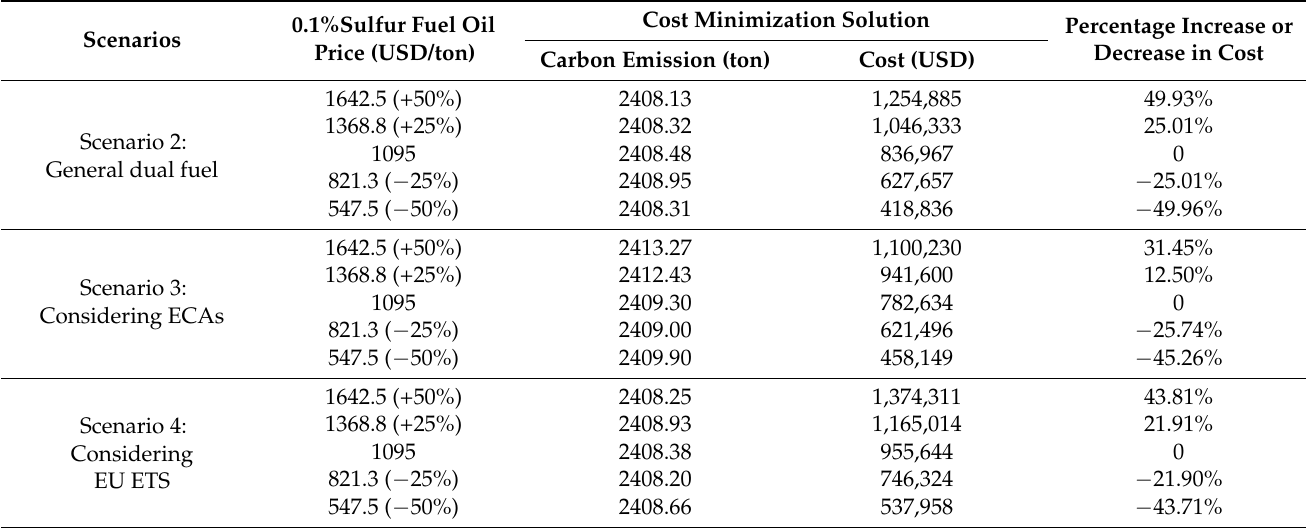
Table 6. Sensitivity analysis conducted with respect to the 0.1% sulfur fuel oil